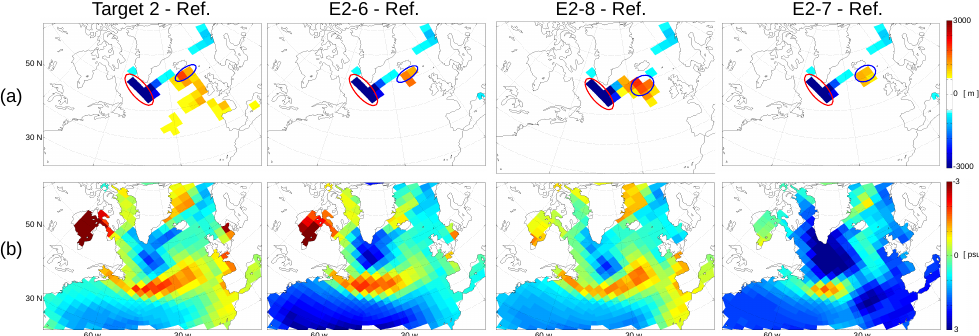
Fig. 6. Anomalies in Target 2, E2-6, E2-8, and E2-7 compared to the reference state: the maximum monthly averaged mixed layer depth (a) , and the sea-surface salinity (b) . In (a) , the deepest convection site is shown as a red ellipse for the reference state and as a blue ellipse for Target 2 and each experiment. The pseudo data with MARGO errors - Ref. E3-1 - Ref. E3-3 - Ref.E3-2 - Ref. Target 3 - Ref.